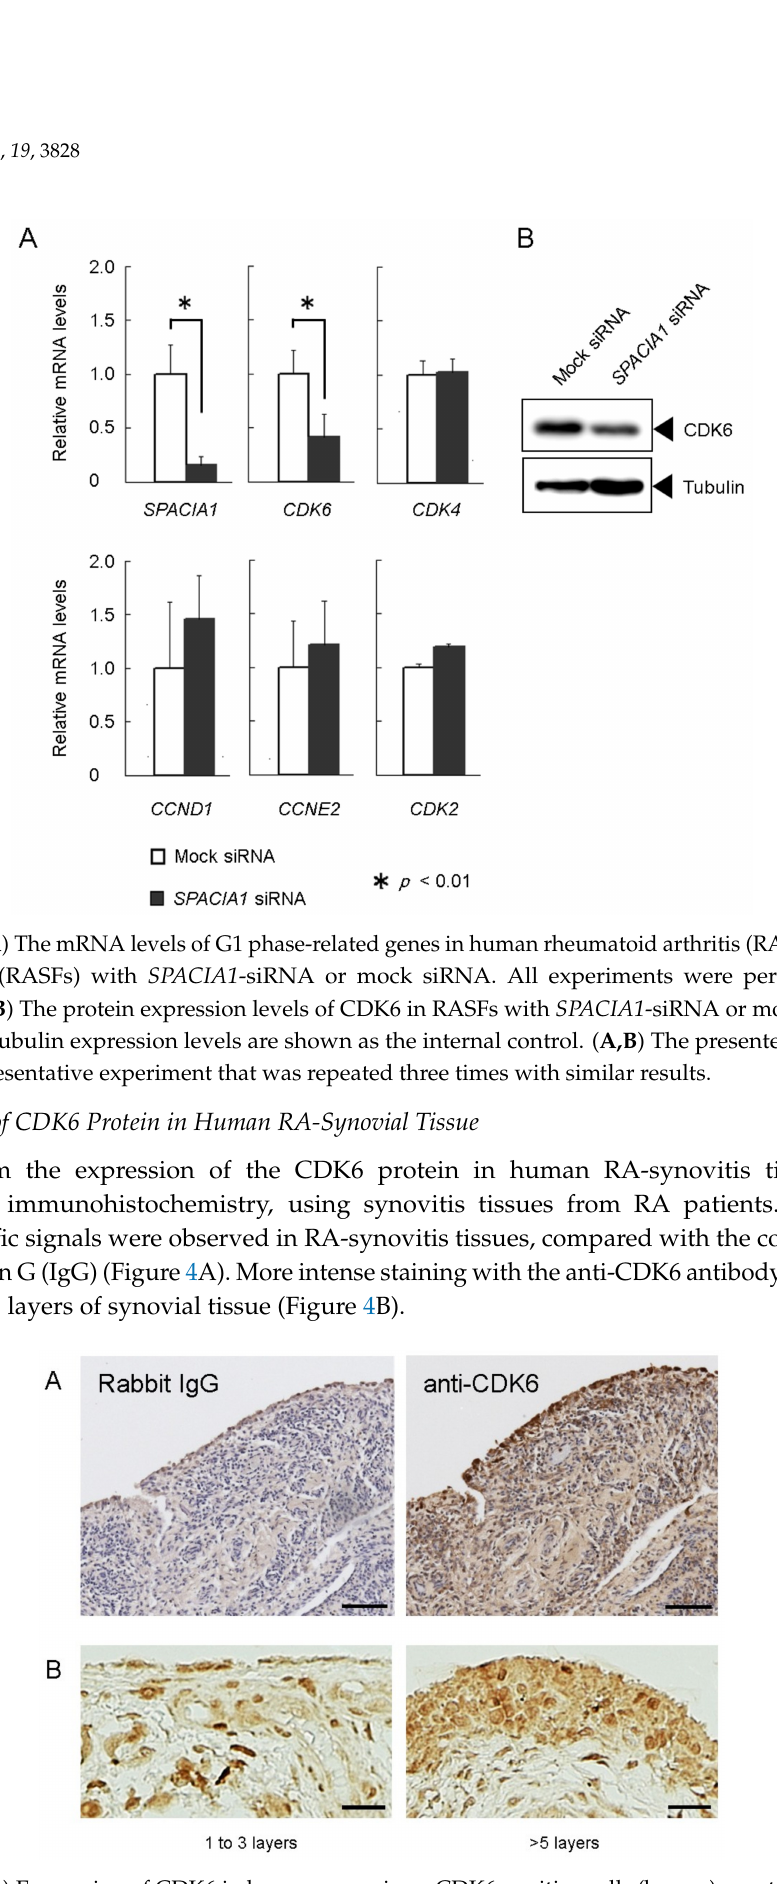
Figure 4. ( A ) Expression of CDK6 in human synovium. CDK6-positive cells (brown) are stained with 3,3 (cid:48)